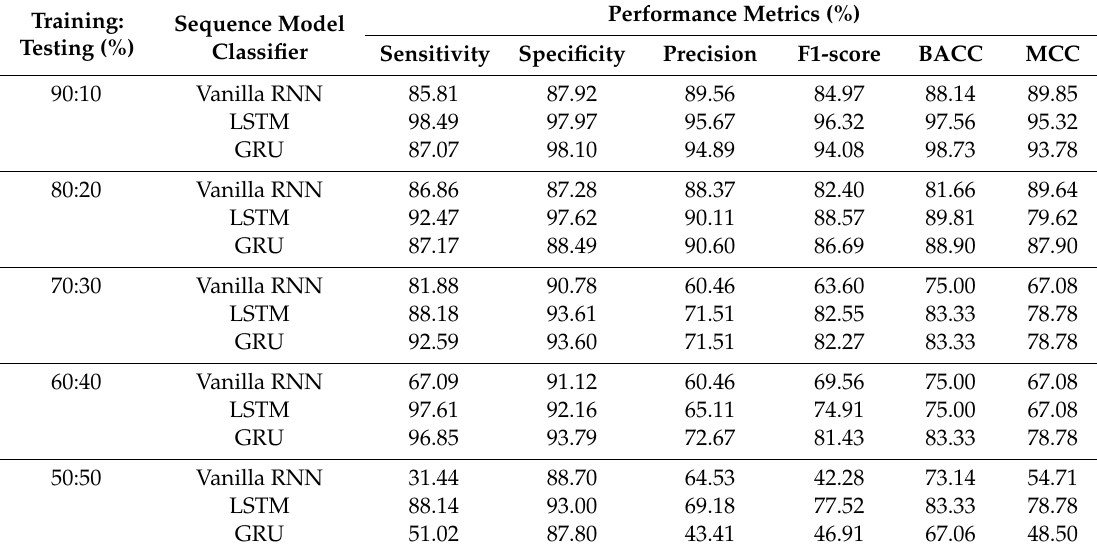
Table 3. The result of the sequence model classifier